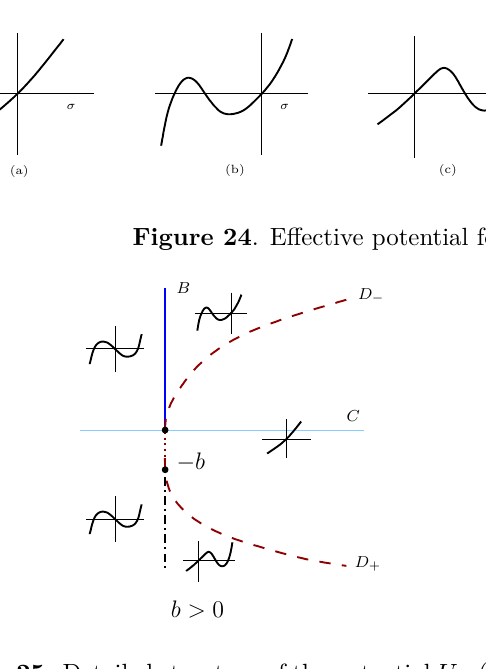
Figure 25 . Detailed structure of the potential U eff ( σ ) (C.1) for Case I: A > 0 , A + a > 0 . The solid blue (resp. dashed-dotted black) lines signify a local minimum (resp. local maximum) crossing from one branch to the other through σ = 0 . The red dashed lines D + and D − signify the (dis)appearance of new extrema in the potential (cf. (C.3)). The dotted red line segment between B = 0 and B = − b signifies a local maximum in one branch and a local minimum in the other meeting at σ = 0 . The solid green line is a first order phase transition line which signifies the presence of two equal local minima of the potential, one in each branch.